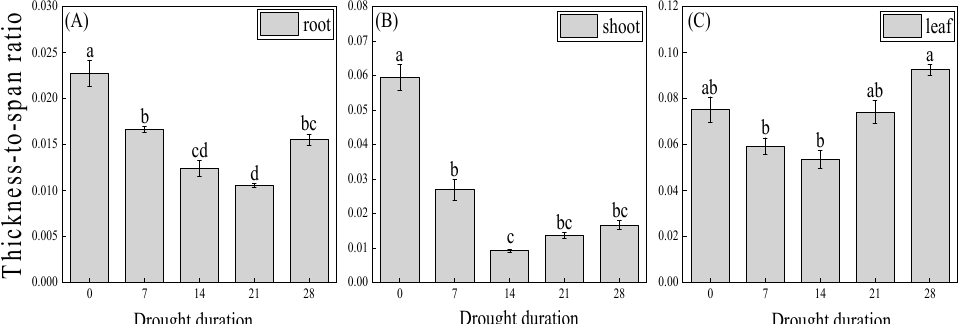
Figure 9. The thickness-to-span ratio in the xylem of P. euphratica without (0-days) and with drought (day 7 to 28). ( A ): root, ( B ): shoot, ( C ): leaf. Different lower-case letters denote significance levels based on analysis of variance (ANOVA) post hoc means with least significant difference (LSD) analysis ( p < 0.05). Data are means with standard error.